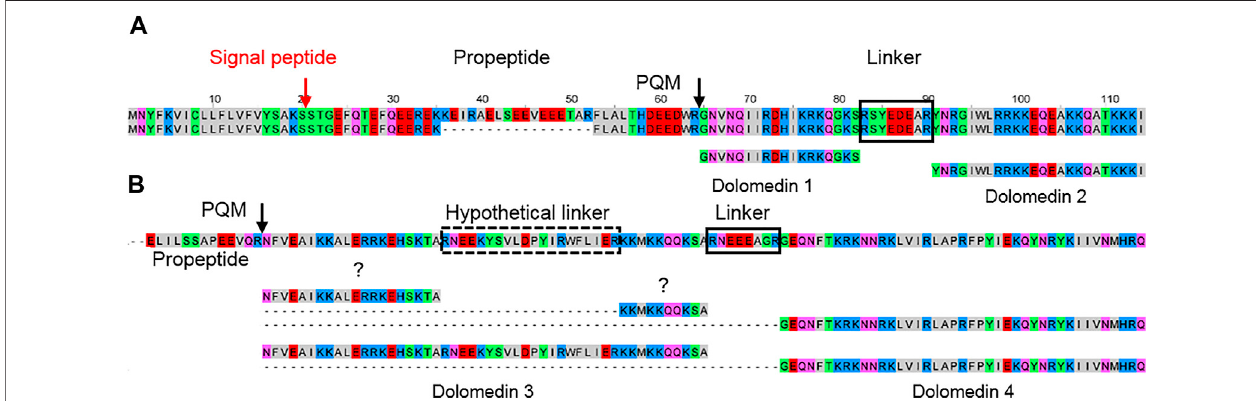
FIGURE 9 | Hypothetical posttranslational processing of two peptide precursors of Dolomedes oke fi nokensis . (A) Peptide precursors of dolomedin 1 and 2. (B) Peptide precursor of dolomedin 3 and 4. After removing signal peptide and propeptide by speci fi c proteases, the remaining peptide chain can be further processed by